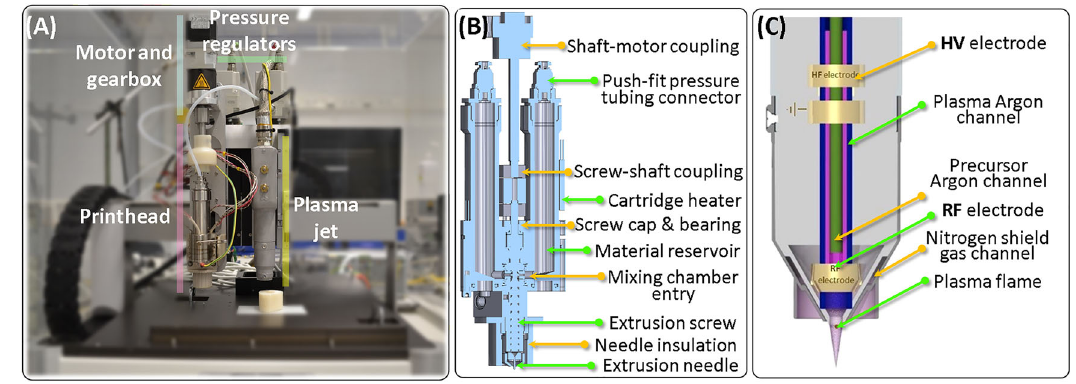
Fig. 1 Hybrid AM platform. A printhead for mixing and extruding two materials ( A , B ); and an atmospheric plasma jet ( A , C ) were developed and mounted on a commercial printer platform ( A ). B Schematic of the printhead, capable of varying the extruded material composition during the printing, by varying the ratio of the two feed materials using gas pressure applied to each material. C Schematic of the plasma jet used to activate surfaces with an inert gas (Ar tested here) plasma, as well as of depositing fi lms of plasma-polymerized precursors (up to two precursors, fed to the plasma using carrier gas bubbling in the precursors and controlling precursor amount using gas mass fl